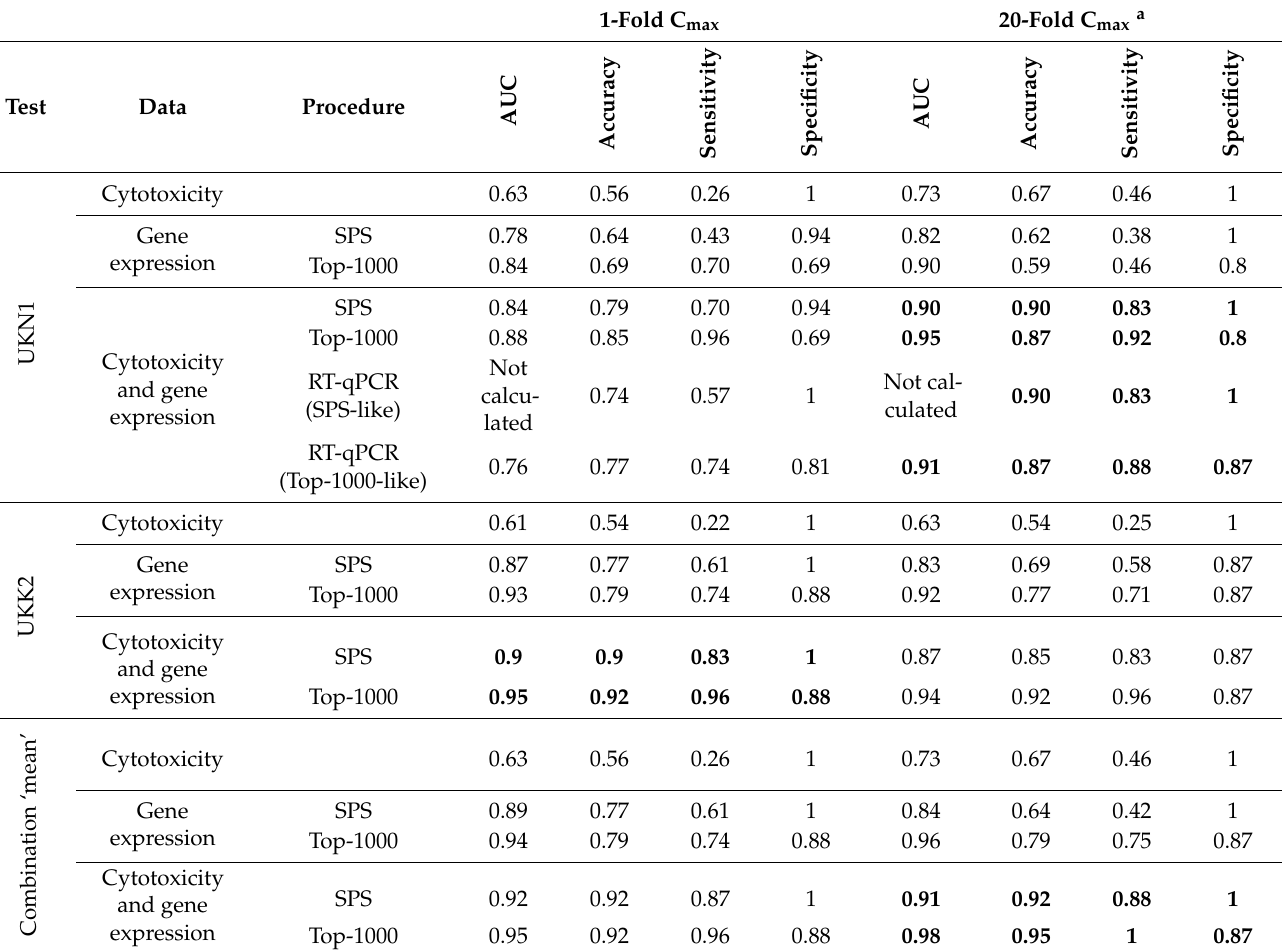
Table 3. Performance metrics of the classification procedures in the UKN1 test, the UKK2 test, and the combination